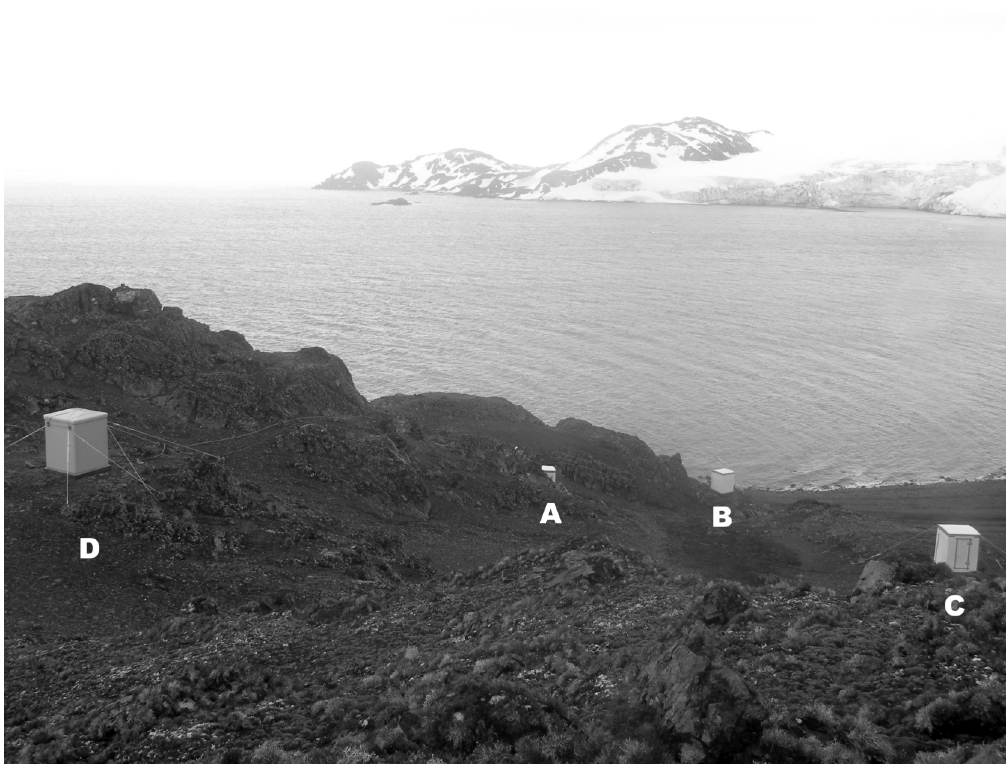
Fig. 4. LIV geomagnetic observatory instrument accommodation. The A, B and C huts correspond to the ob- servatory during 1996-2007. They hold the electronics, the absolute instrument and the D/I magnetometer, re- spectively. The new hut, D, holds the FGE magnetometer deployed during the 2007-2008 summer